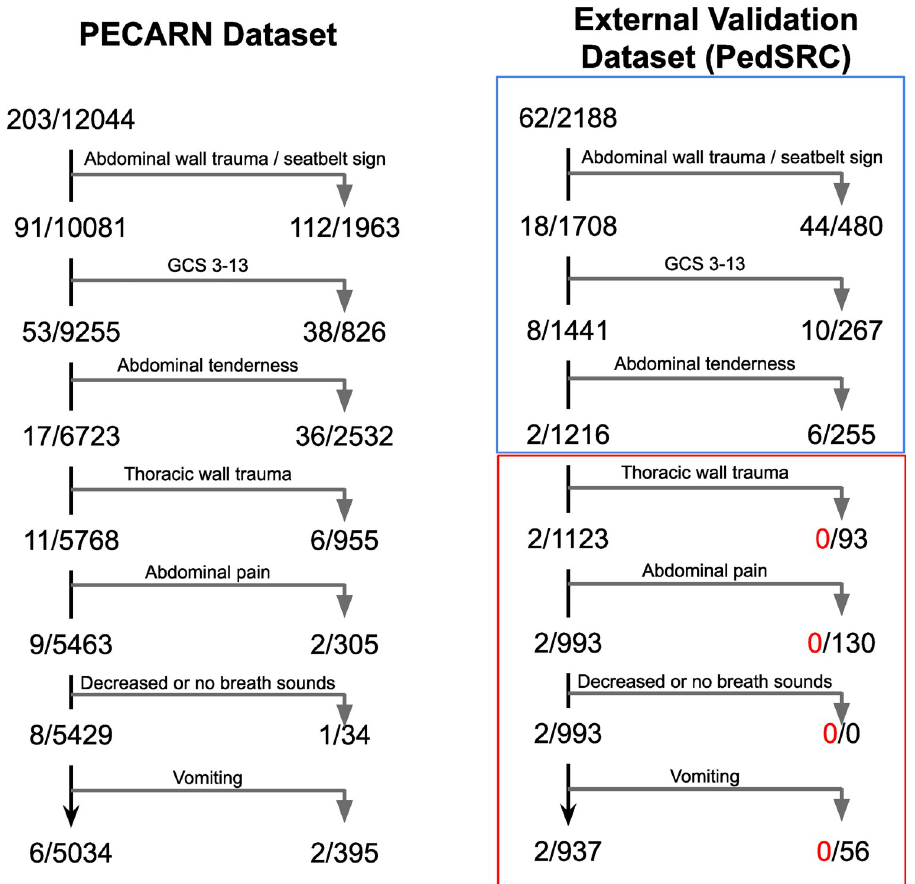
Fig 3. Prediction tree for the original PECARN clinical decision instrument on (a) PECARN internal validation dataset, and (b) PedSRC external validation dataset. The blue box shows that the top three predictor variables retained all the predictive power for the clinical decision instrument on external validation. The red box shows the predictor variables without prediction power on external validation. From the top of the rule to the bottom, risks for the identified subgroups monotonically decrease, although risks are systematically higher on the PedSRC